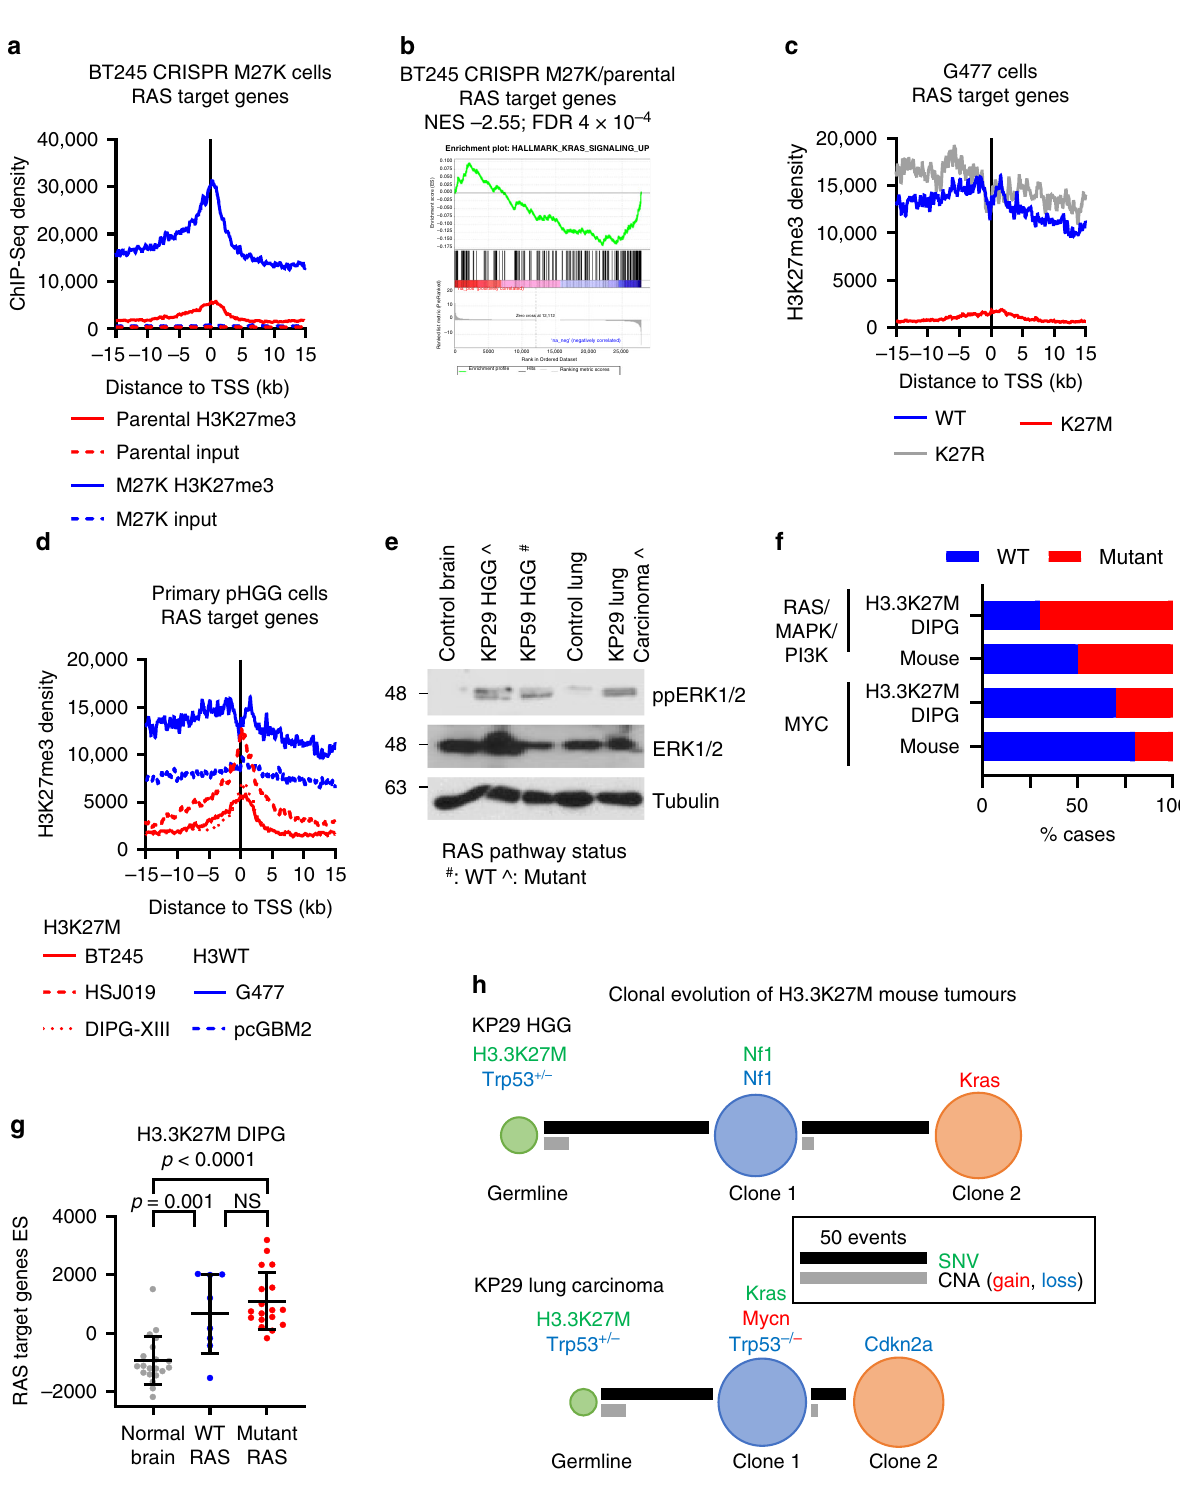
(Fig. 7k, l, Supplementary Fig. S7k, l) supporting these